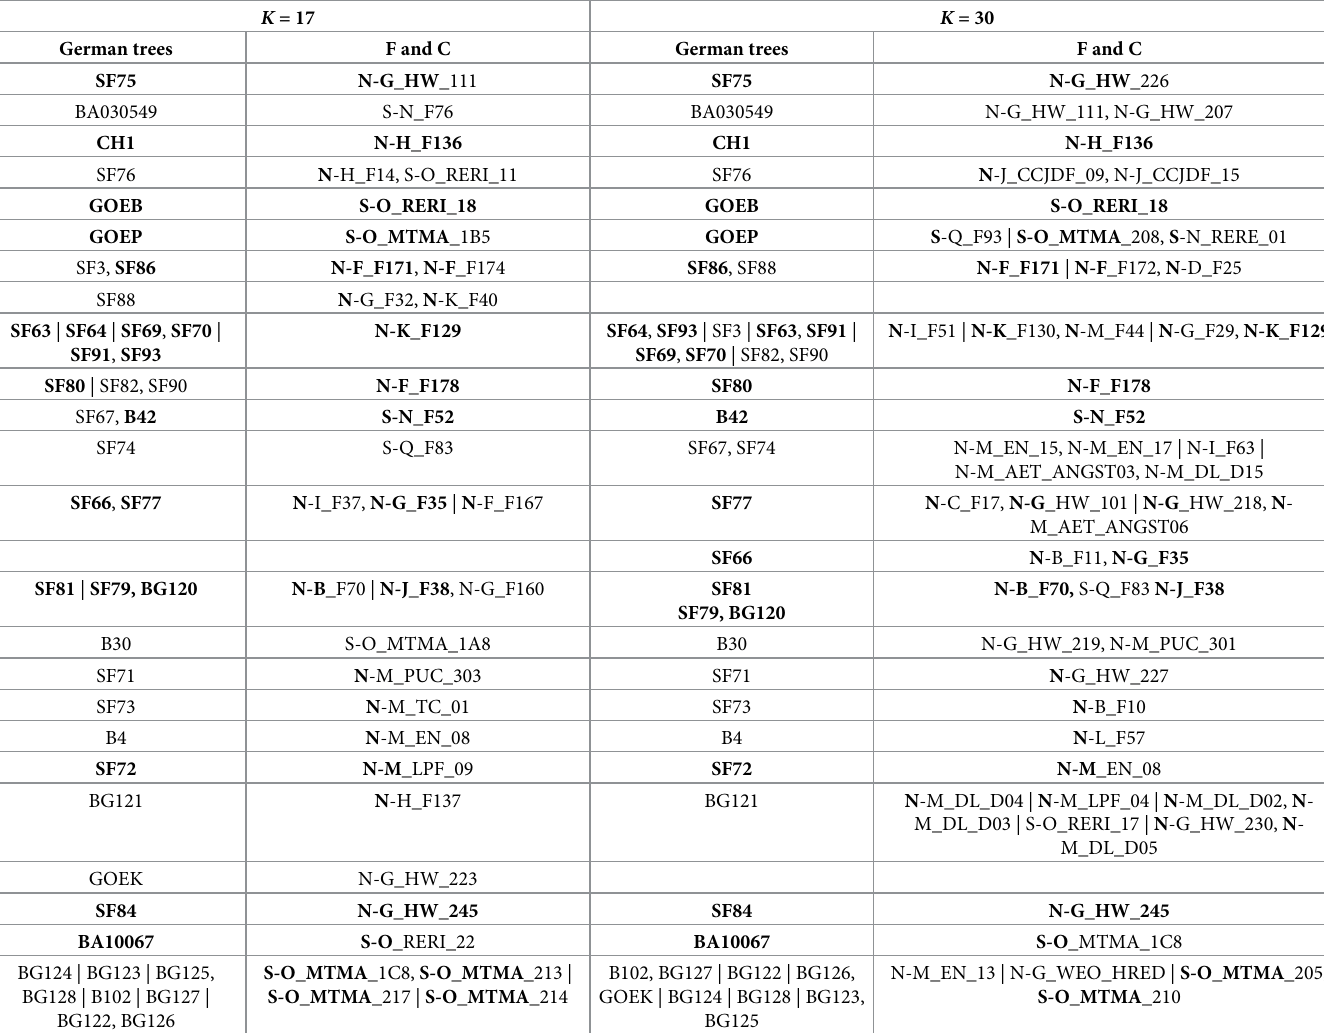
Table 2. German trees in the data set G clustered together with genetically similar trees representing different watersheds (S9 and S11 Figs) and groups (S10 and S12 Figs) in French and Californian data sets F and C, respectively, based on the pairwise similarity in composition of Q -values obtained by STRUCTURE for K = 17 and K =